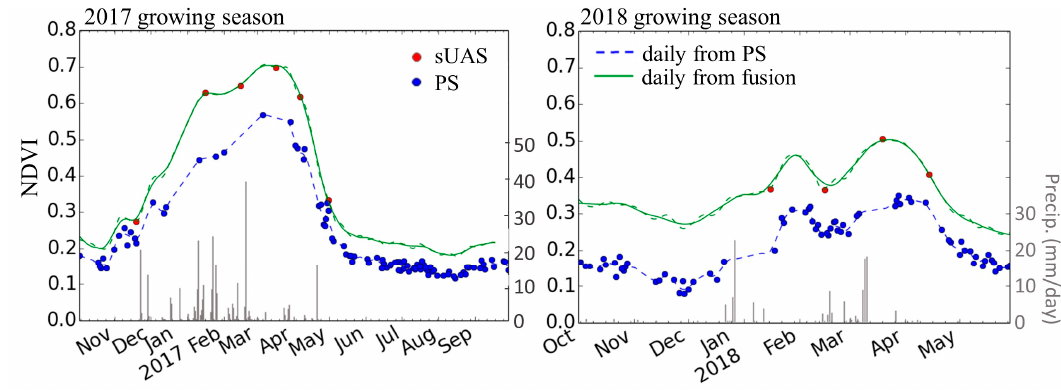
Figure 5. NDVI time series of a randomly selected grass pixel over a relatively homogeneous area, from 10 sUAS missions (6 and 4 in the 2017 and 2018 growing season respectively), PlanetScope (PS), and data fusion. Also shown is daily precipitation (grey bar) from the on-site rain gauge measurement.